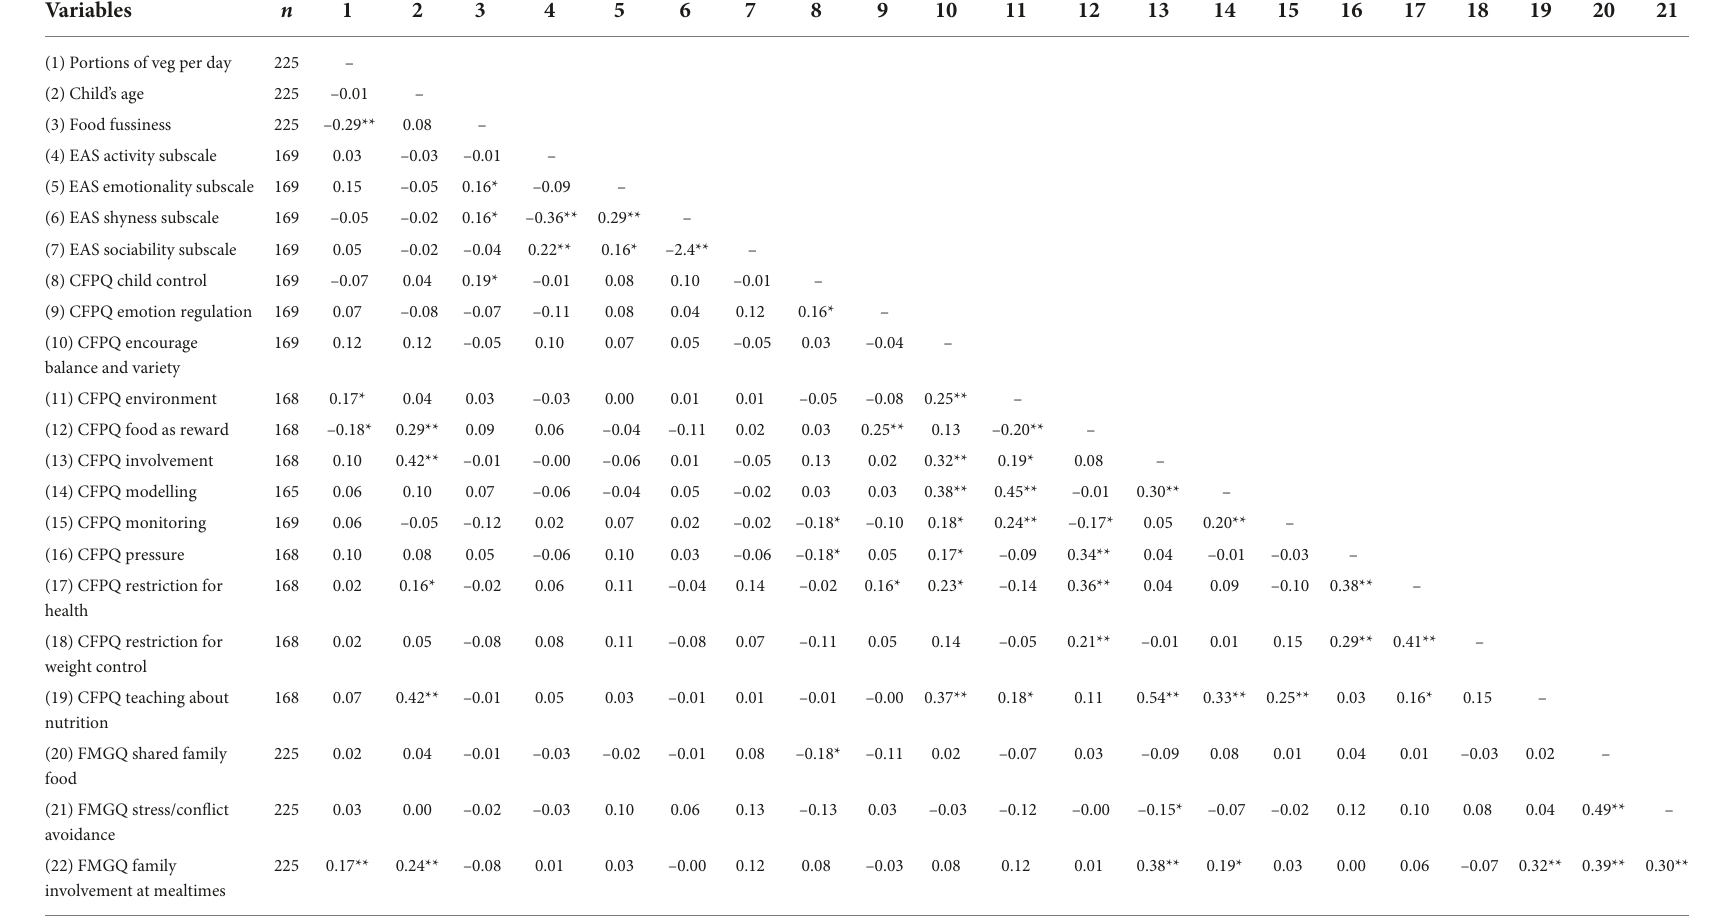
TABLE 6 Correlations between vegetable consumption and parent and child measures, UK sample ( N = 225) ††† .